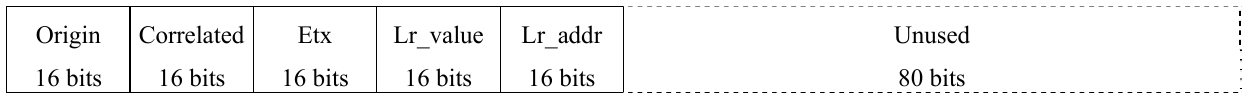
Figure 7. Correlation packet length (version 2).